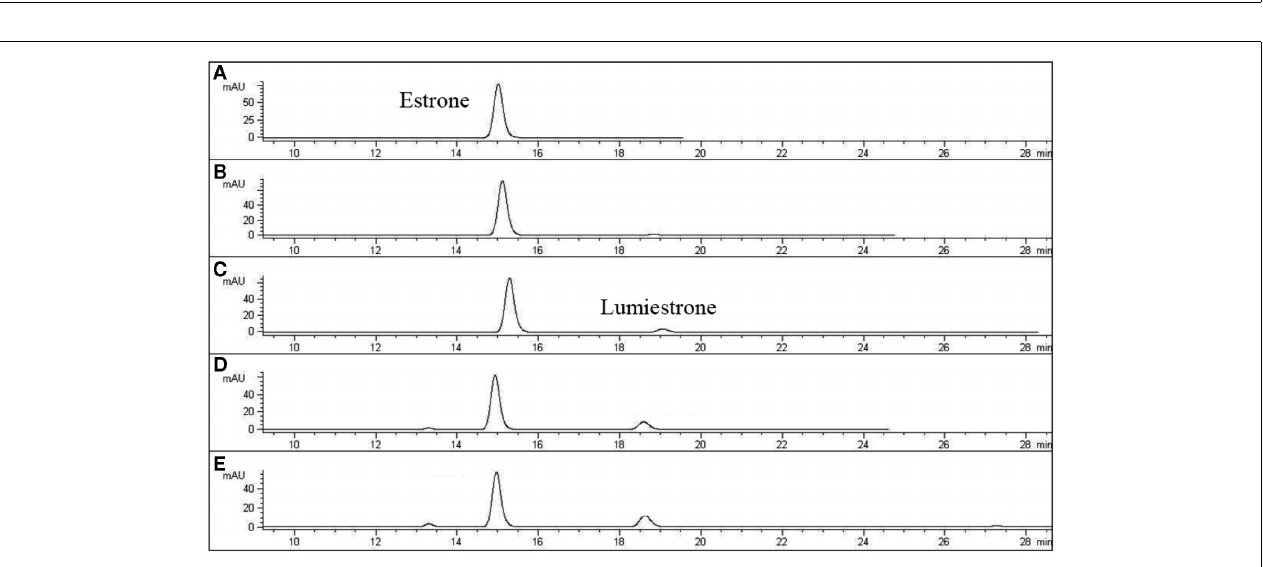
FIGUREA3 | High-pressure liquid chromatography chromatograms of estrone solutions (10 μ M) irradiated by sunlight at different times. (A) t = 0, (B) t = 15, (C) t = 60, (D) t = 120, and (E) t = 180min. In order to simulate environmental conditions estrone was dissolved in untreated sewage water and irradiated by sunlight in Napoli (Italy) in July 2007. HPLC analysis was performed under isocratic conditions (H 2 O/CH 3 CN 1:1) on an Agilent 1100 Binary HPLC pumps system equipped with a UV-detector.The column used was a reverse-phase Gemini 5 μ C-18 (250 × 4.60mm).The detector was set at 220nm.